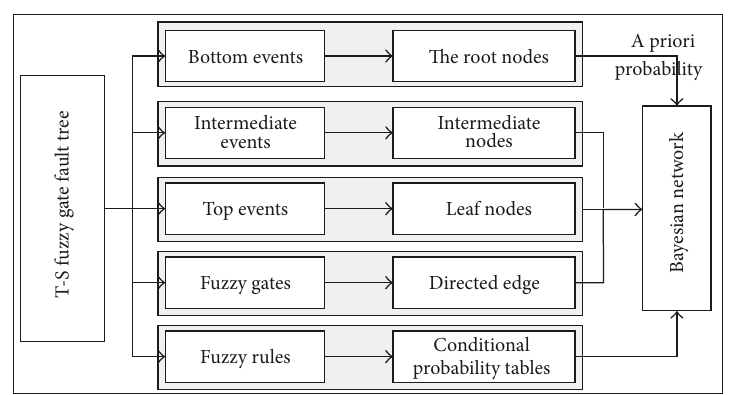
Figure 3: T-S fuzzy tree converted into